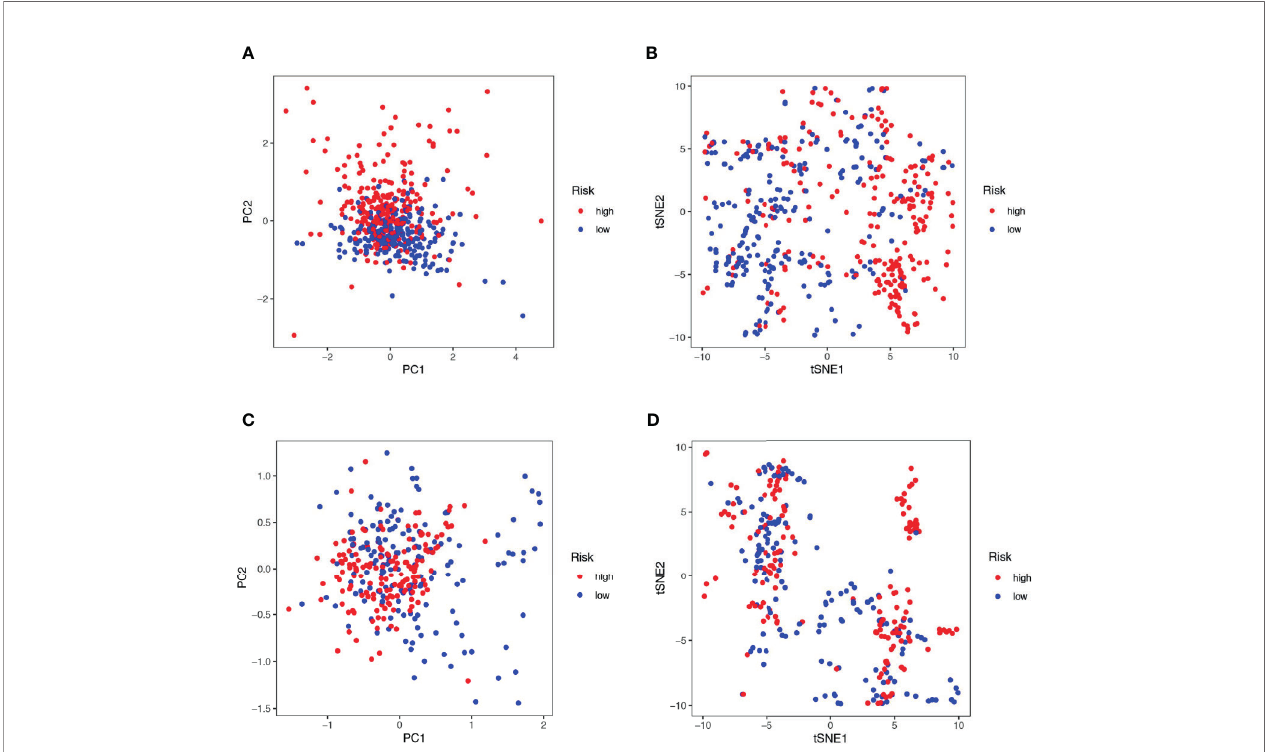
FIGURE 3 | (A, C) Principal component analysis (PCA) plot in the TCGA and three GEO cohorts. (B, D) t-distributed stochastic neighbor embedding (tSNE) analysis in the TCGA and three GEO